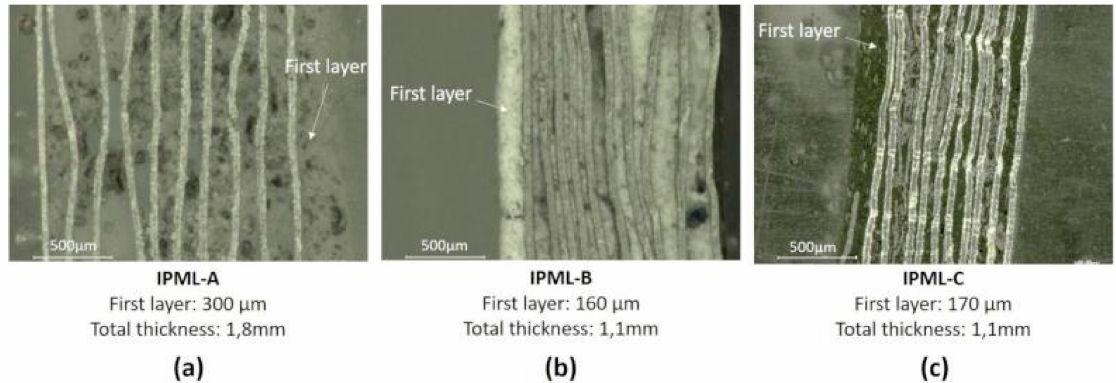
Figure 5. Cross section pictures obtained by microscopic analyses of ( a ) IPML A, ( b ) IPML-B, and ( c ) IPML-C, before burn-through test.